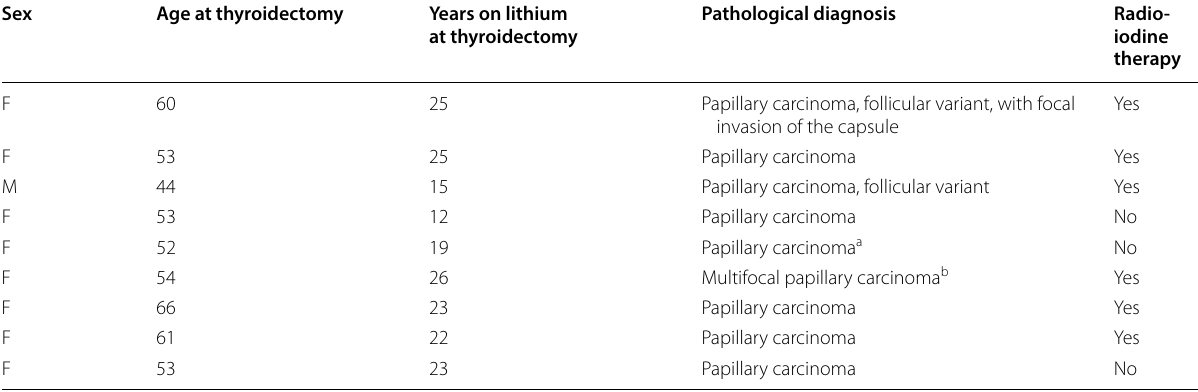
a Case report with concurrent renal oncocytoma described in this paper b Case already reported in a follow-up study of a cohort of 150 patients (Bocchetta et al.